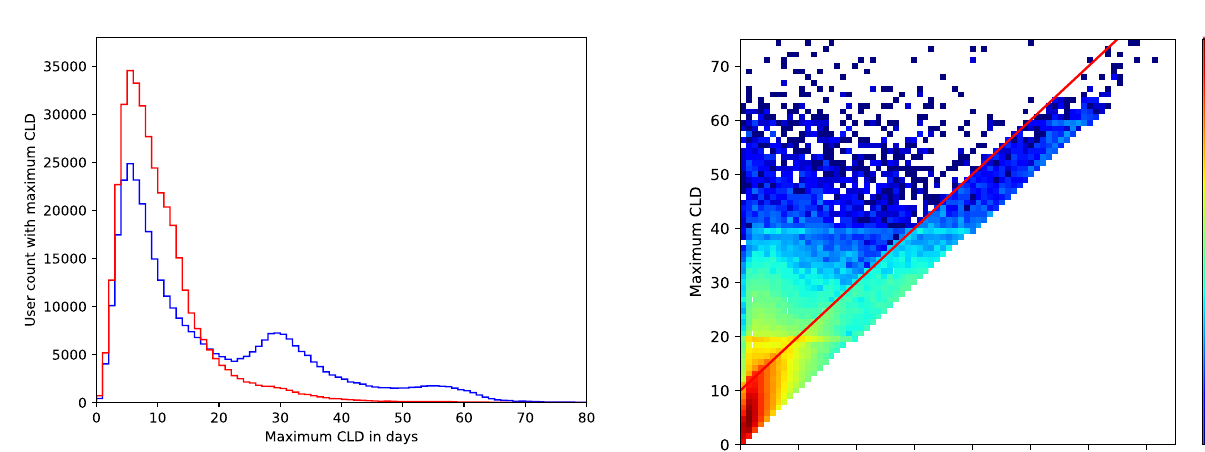
We further validate our method by examining tracking activity during the interval where a user is expected to track their period for each of these excluded cycles and fi nd that in 89.18% of such cases, there is no evidence of bleeding-related events during this interval, i.e., the user likely did not engage in period tracking. Note that we de fi ne this interval as the user ’ s last reported period day plus their median cycle length, plus or minus their median period length. In the remaining 10.82% of excluded cycles, it is unclear whether the bleeding-related events tracked during this interval represent a period or some other non-period bleeding. Note that by our de fi nition of a period, a single bleeding event is not synonymous with